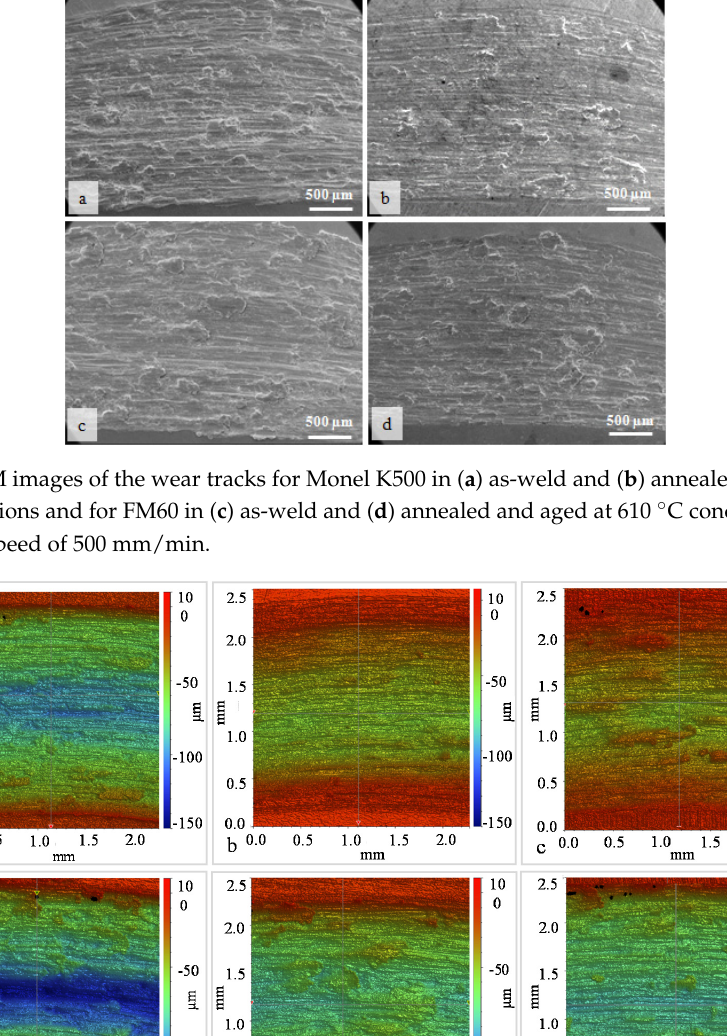
Monel K500 was higher than in FM60 for all studied conditions (except for 300 mm/min deposition